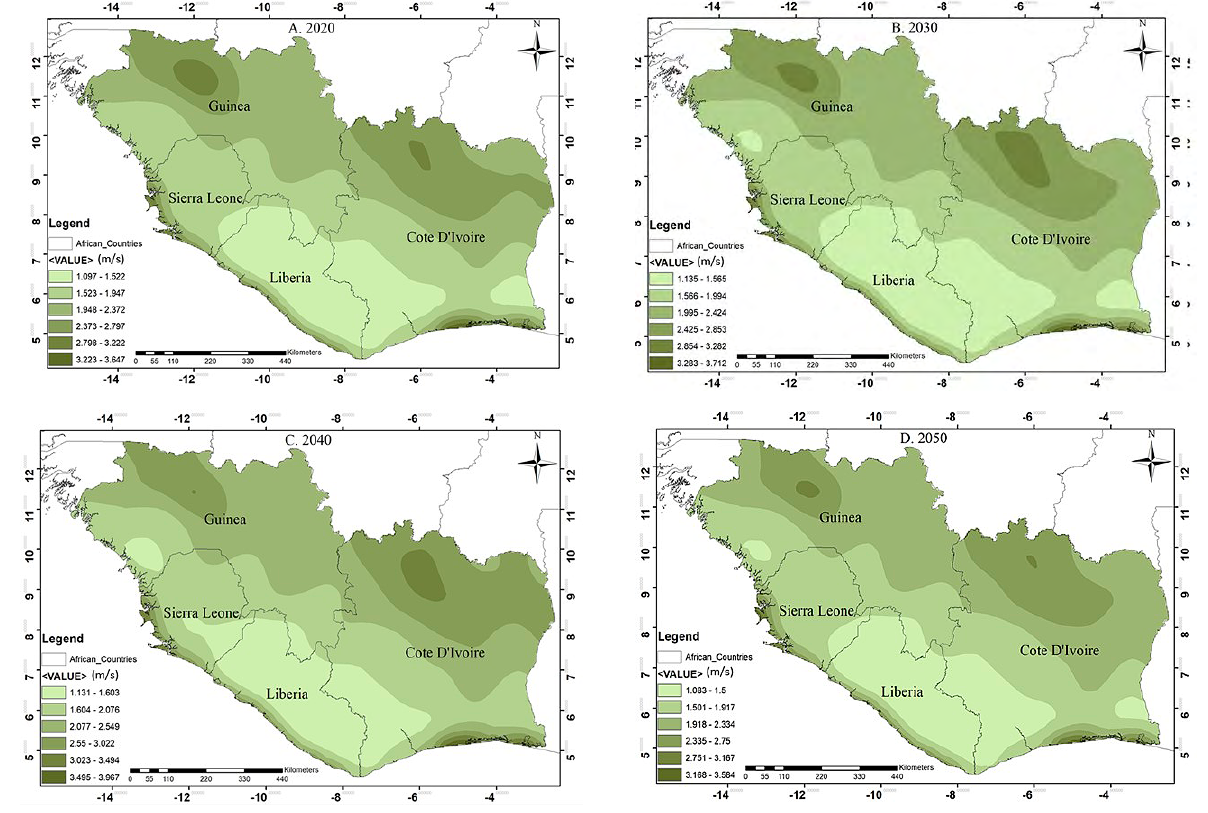
Figure 6. Decadal Spatial Distribution of Wind Speed (m/s) in the MRU region for the period